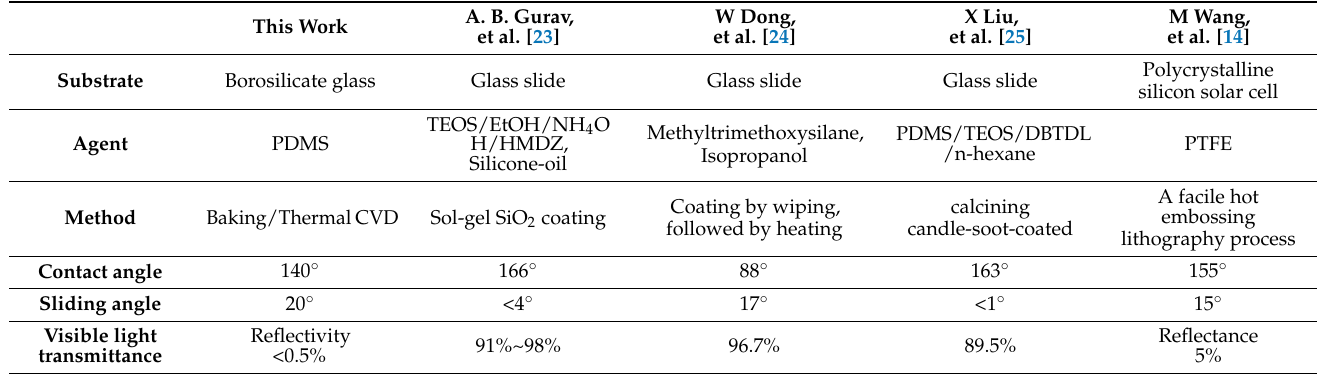
Table 1. Specification and performance comparison of water-repellent and anti-reflective